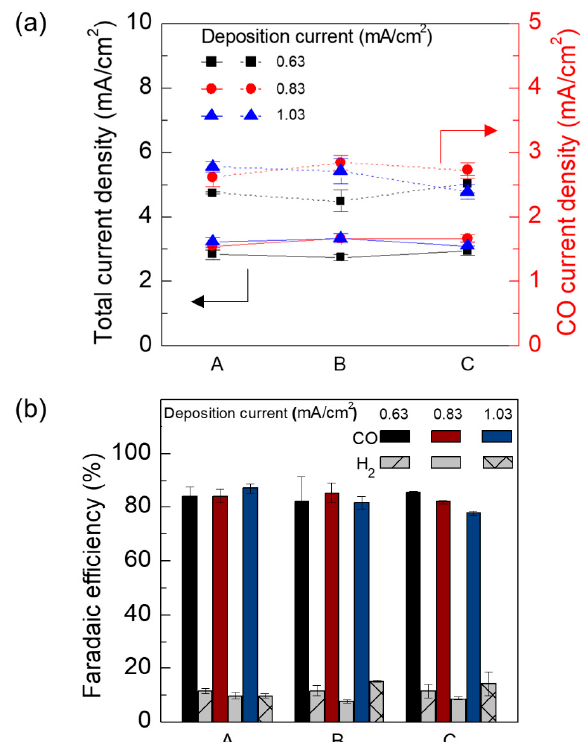
Figure 3. ( a ) Total electrolysis current density and CO production current density of the 25.5 cm 2 Ag GDE according to the position and ( b ) the corresponding FE for CO and H 2 . Ag deposition was performed with di ff erent deposition current densities (0.63, 0.83 and 1.03 mA / cm 2 ) for 50 min with a fixed working-counter electrode distance of 4 cm. The CO 2 reduction was performed at a